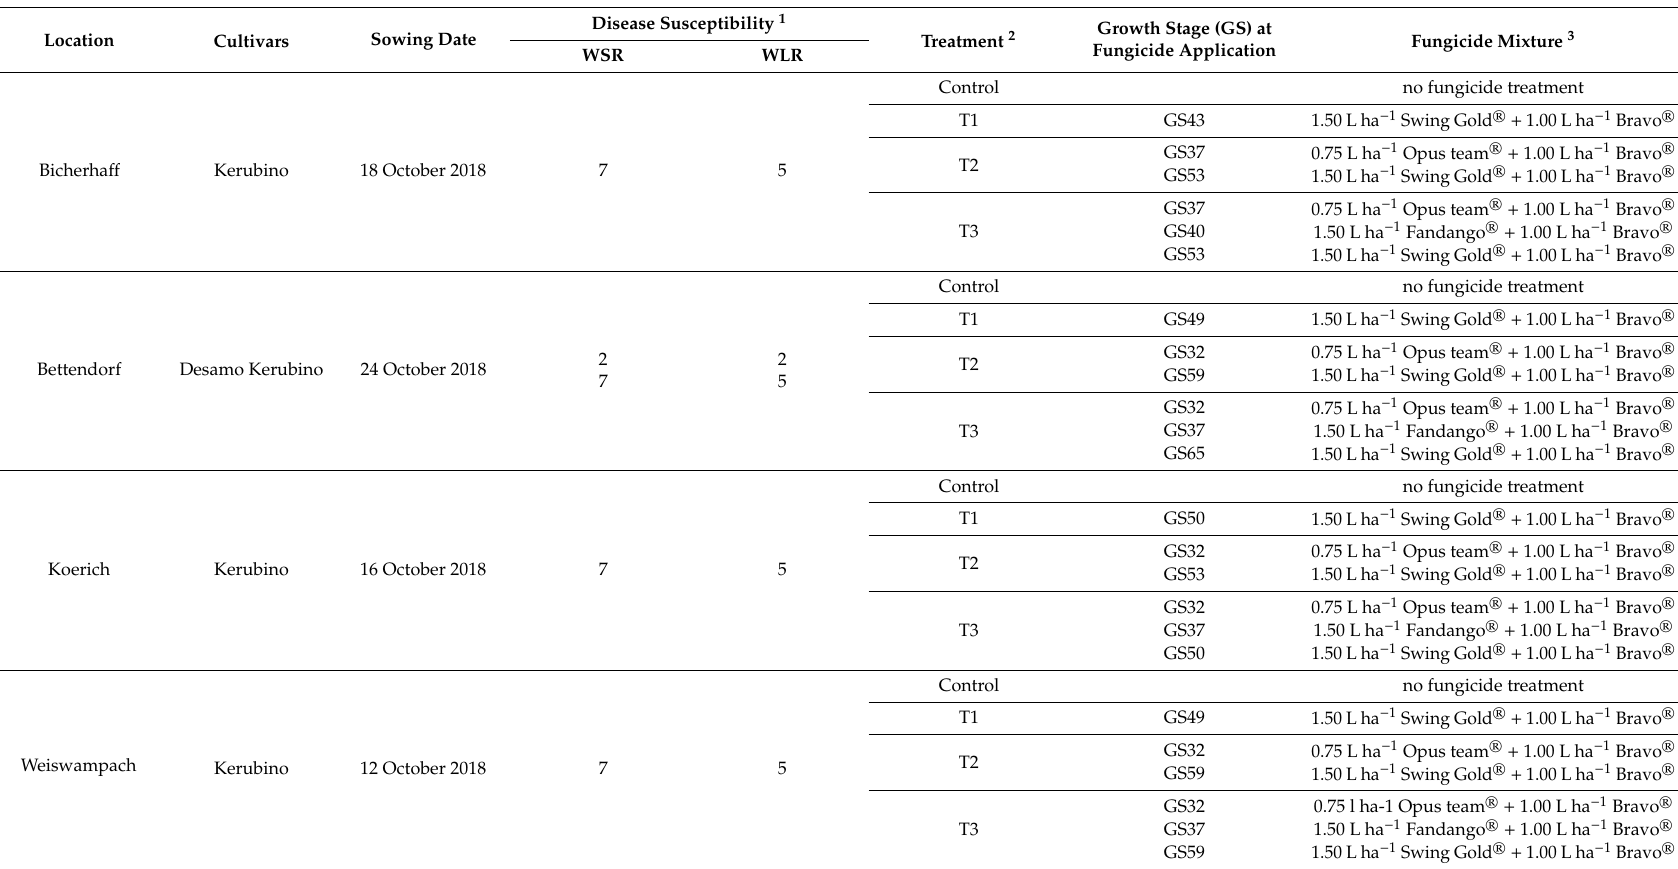
1 Scale of susceptibility for wheat stripe rust (WSR) and wheat leaf rust (WLR): 1 (low susceptibility) to 9 (high susceptibility) [35]. 2 T1, T2 and T3 refer to single, double and triple fungicide treatments, respectively. 3 The products Bravo ® , Fandango ® , Opus team ® , and Swing Gold ® contain the active ingredients chlorothalonil (500 g L − 1 ), prothioconazole (100